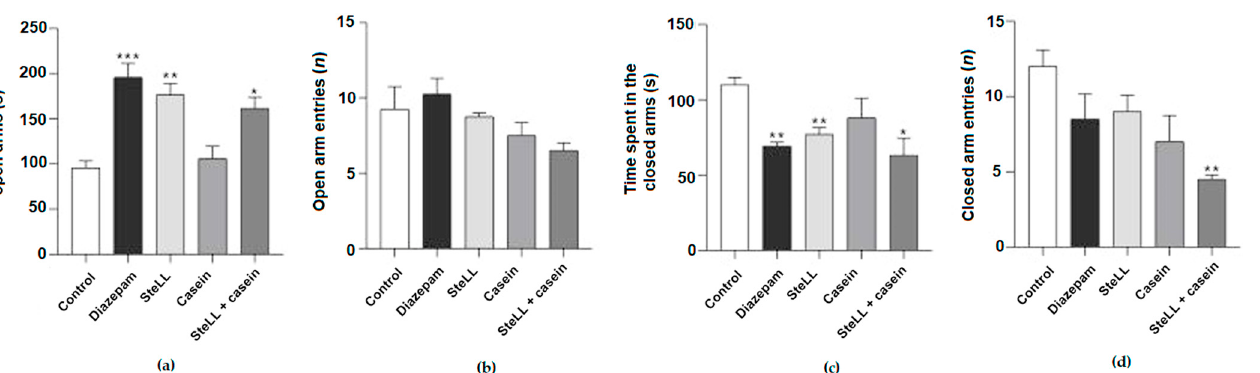
Figure 4. The incubation of the lectin with casein did not revert the anxiolytic effect of SteLL (4 mg/kg) in the open field test. ( a ) Total number of crossings. ( b ) Total number of rearings. (*) p < 0.05; (**) p < 0.001; (***) p < 0.0001 compared to control. 2.3. The Anxiolytic Effect of SteLL in the EPM Is Dependent on Monoaminergic Pathways To investigate whether the anxiolytic-like effect of SteLL in the OFT and EPM was dependent on monoaminergic pathways, the following antagonists were administered 15 min before the SteLL treatment: the nonselective antagonist of the α 2-adrenoceptor (yo- himbine), the 5-HT2A/2C serotonin receptor antagonist (ketanserin), or the D1 dopamine receptor antagonist (SCH 23390). Pretreatment with yohimbine, ketanserin, and SCH 23390 significantly blocked the effect of SteLL (4 mg/kg) on the time spent in the open (Figure 5A; F= 6.608 p < 0.0001) and closed arms (Figure 5C; F = 3.590, p = 0.0058) on the EPM. The number of entries into the open (Figure 5B; F = 1.089, p = 0.4003) or closed arms (Figure 5D; F = 1.407, p = 0.2383) did not significantly change among the groups. In addi- tion, the treatment with antagonists did not affect the efficacy of SteLL in the reduction in the rearing responses on OFT (Figure 6B; F: = 7.851, p < 0.0001). No treatment altered the number of crossings (Figure 6A; F = 3.92, p > 0.05).